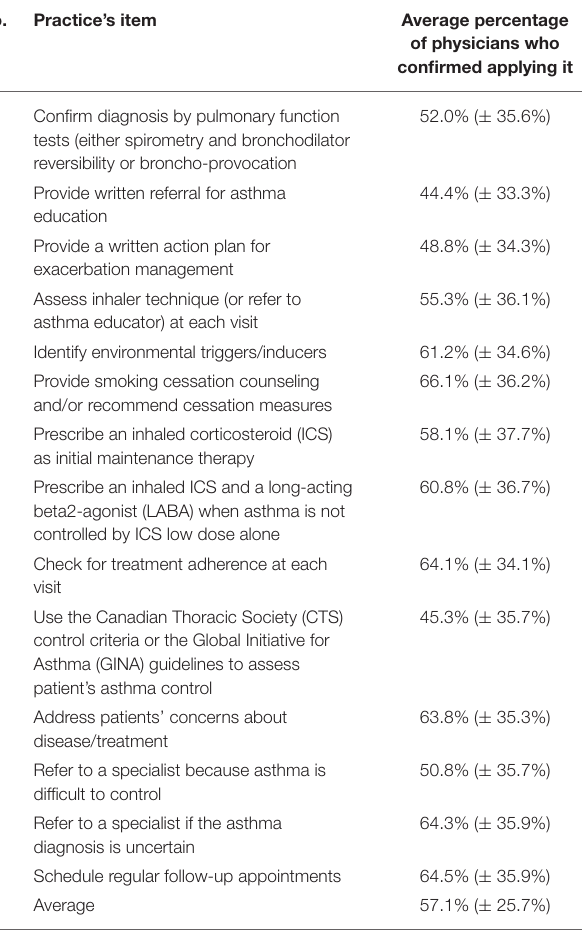
TABLE 2 | Frequency of the study participants answering the asthma knowledge questions right.